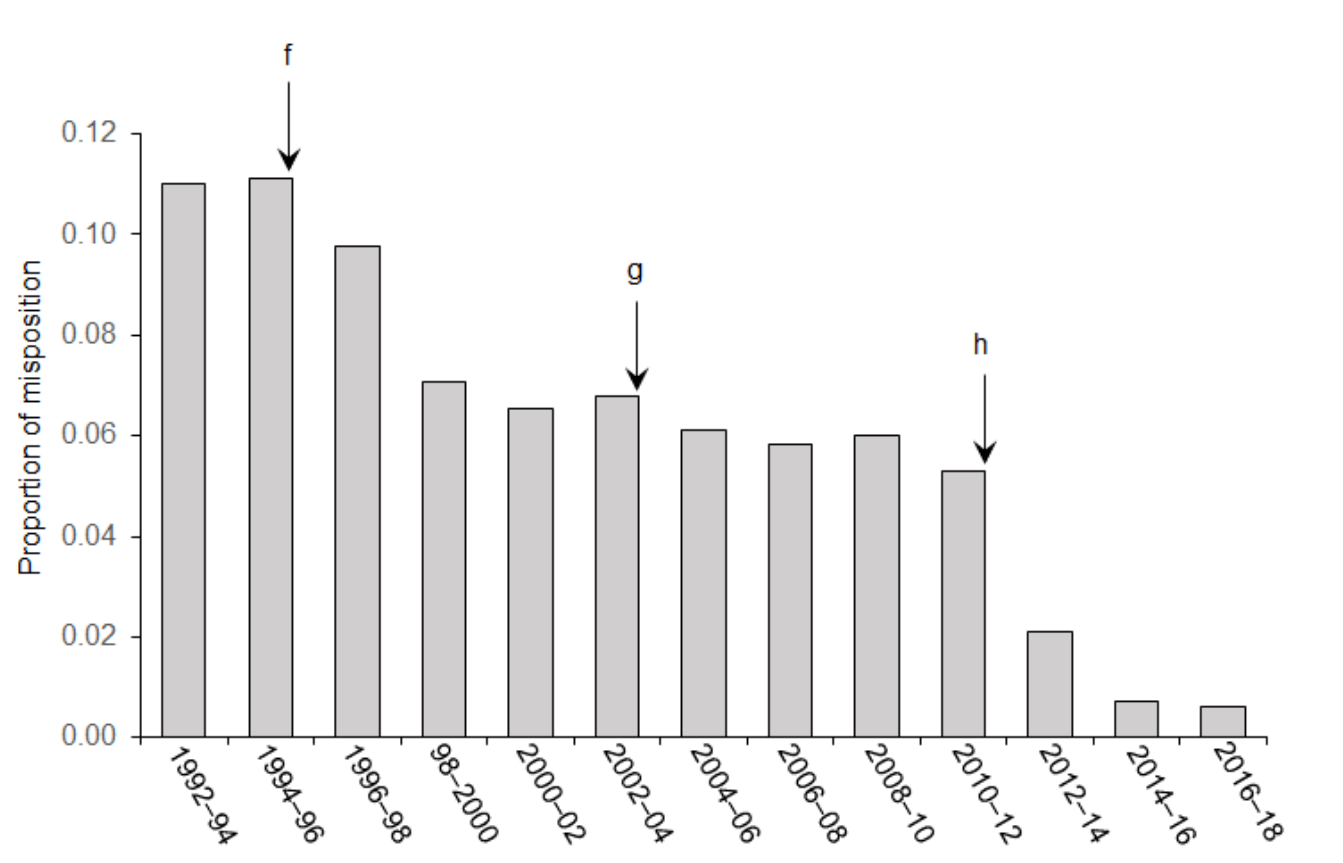
Figure 3. Effect of refinement in the stereotaxic procedure on the accuracy of placement of the implanted item(s). Letters indicate the chronology of the various improvements introduced in our procedure. ( f ) From 1995, verification of the flat-skull position before each surgical session. Verification of the vertical position of the holders. Introduction of pilot studies and immediate histological verification of implantation site to check the correspondence between the theoretical coordinates and actual placement within the target area. ( g ) From 2004, reduction of the cannula diameter. Final DV coordinate of the target structure is calculated from the dura and systematic verification of the flat position of the skull after screw position and on each animal. ( h ) From 2012, development of a fixed spaced slide for cannulas (bilateral implantation) and systematic verification of the axial position of the skull. Most of the data presented on the graph corresponds to the basolateral and central amygdala, and medial and lateral entorhinal cortex targeted structures.